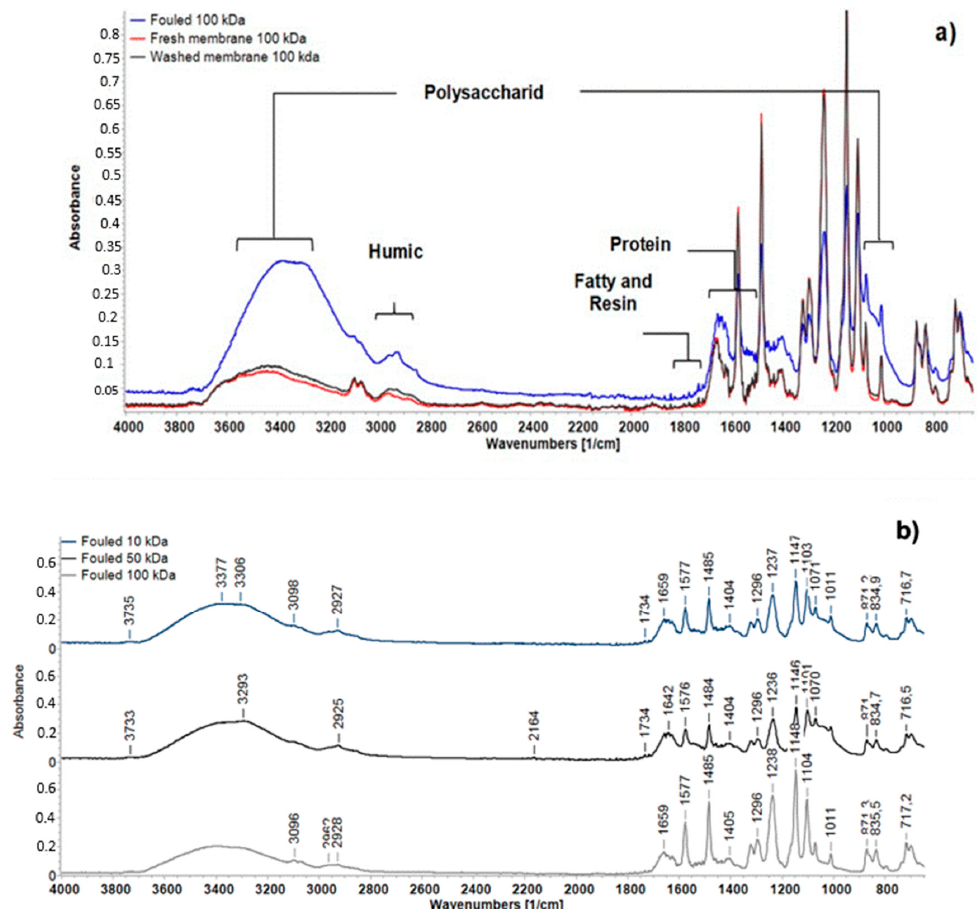
Figure 9. Attenuated total reflection-Fourier transform infrared (ATR-FTIR) spectra comparison of fresh PES membrane, fouled membrane, and after cleaning membranes procedures ( a ) (the IR spectrum comparison between MWCO membranes were almost the same. Therefore, only the spectra for 100 kDa membrane is shown) and DCS-fouled PES membranes (10 kDa, 50kDa and 100 kDa) by pre-filtered PMTE ( b ).